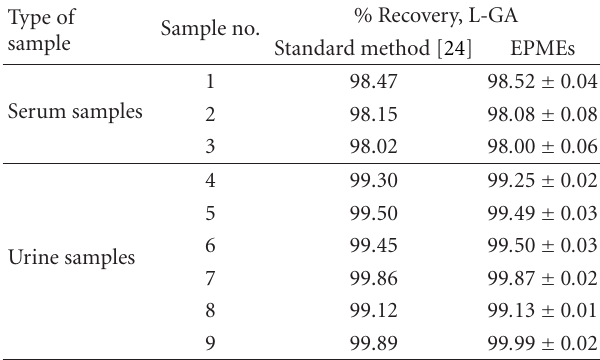
Table 5: Recovery of L-glyceric acid in serum and urine samples, (%) a .